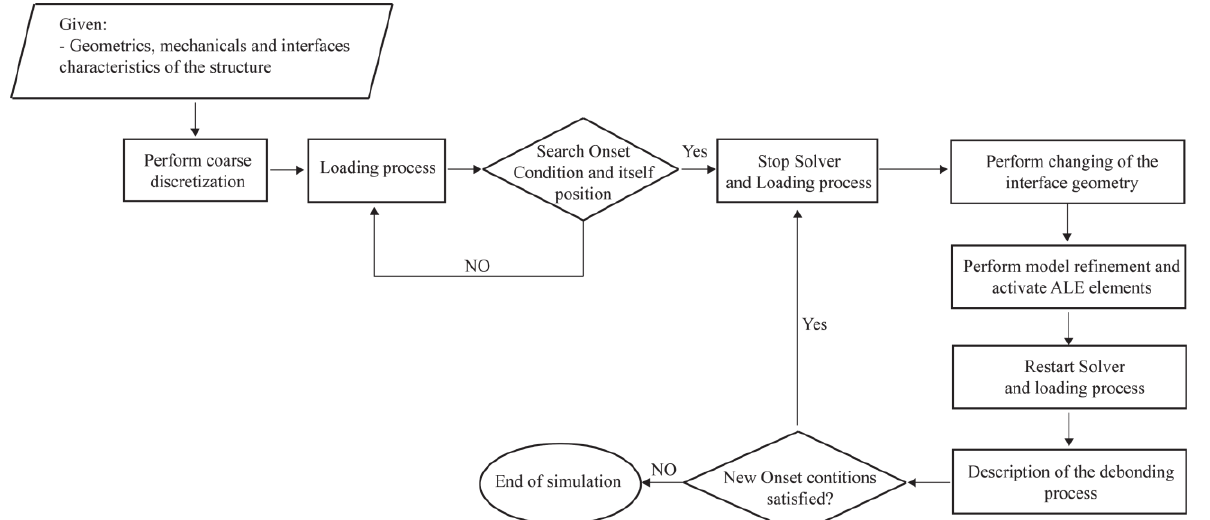
Fig. 3. Representation of the Flow chart implemented in COMSOL